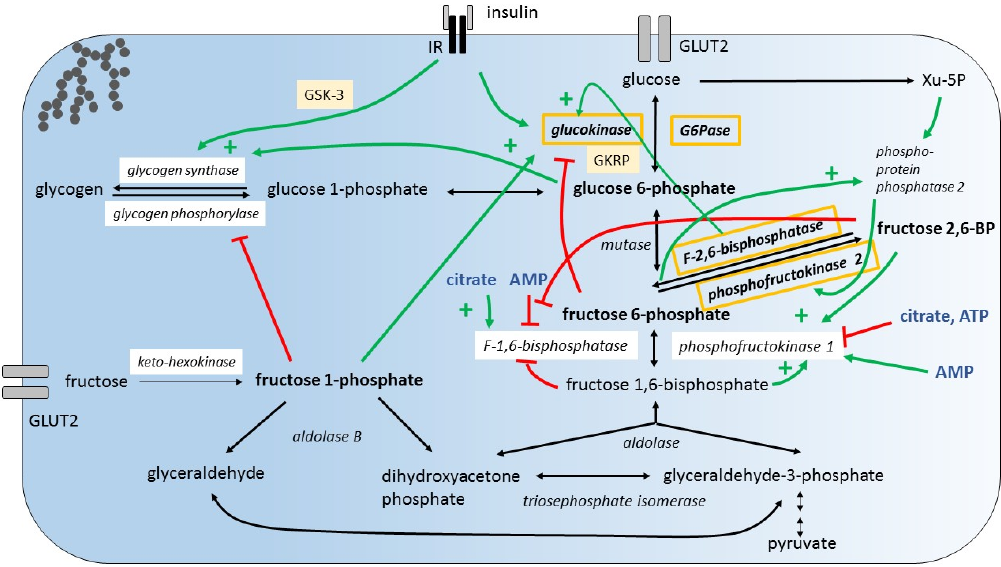
Figure 2. Hepatic hexose uptake and regulatory mechanisms that control hexose breakdown. Glucose and fructose is taken up by glucose transporter 2 (GLUT2). Fructose metabolites regulate key enzymes of glucose metabolism. (A) Fructose stimulates glucose uptake by distinct mechanisms:(1) Fructose 1 ‐ phosphate (F1P) antagonizes the inhibition of glucokinase (GK) by glucokinase regulatory protein (GKRP) promoting glucose 6 ‐ phosphate (G6P) production; (2) newly synthesized G6P stimulates